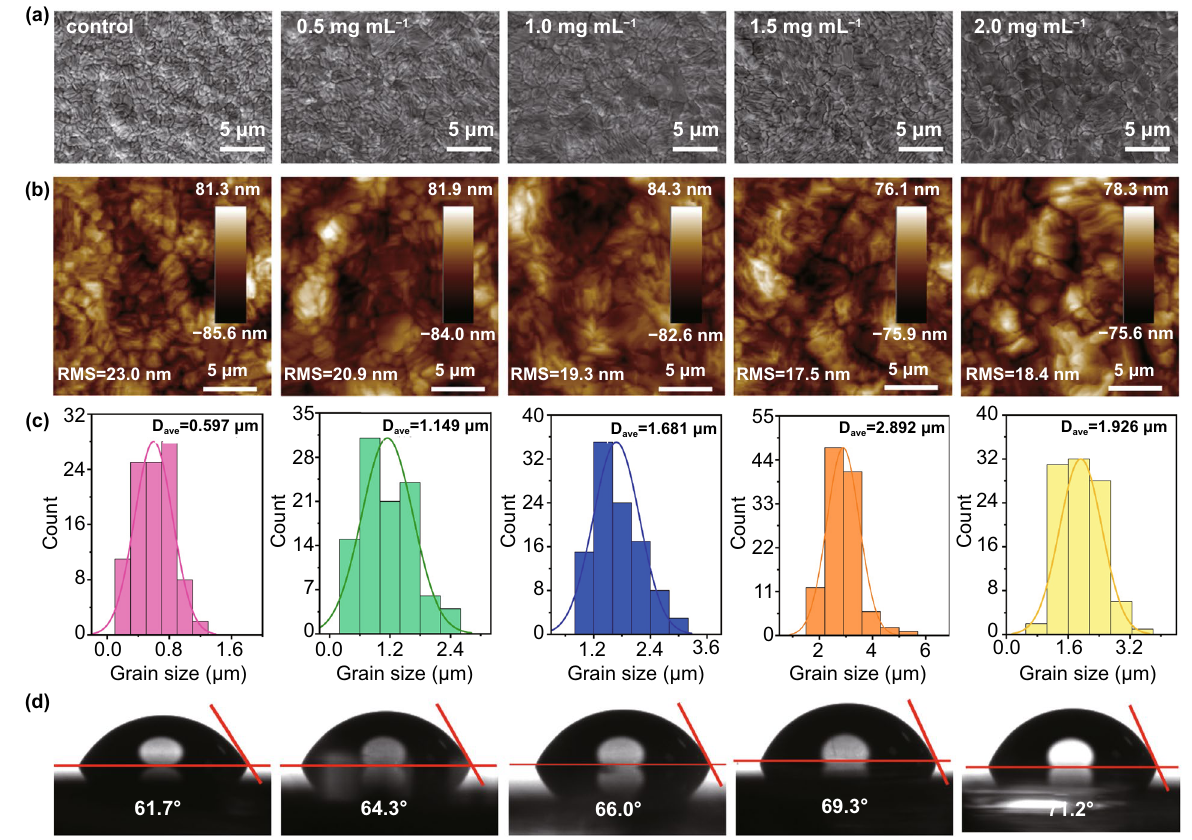
Fig. 4 a Top-view SEM images. b AFM images. c grain size distributions. d contact angles of perovskite films with different concentrations of BBF